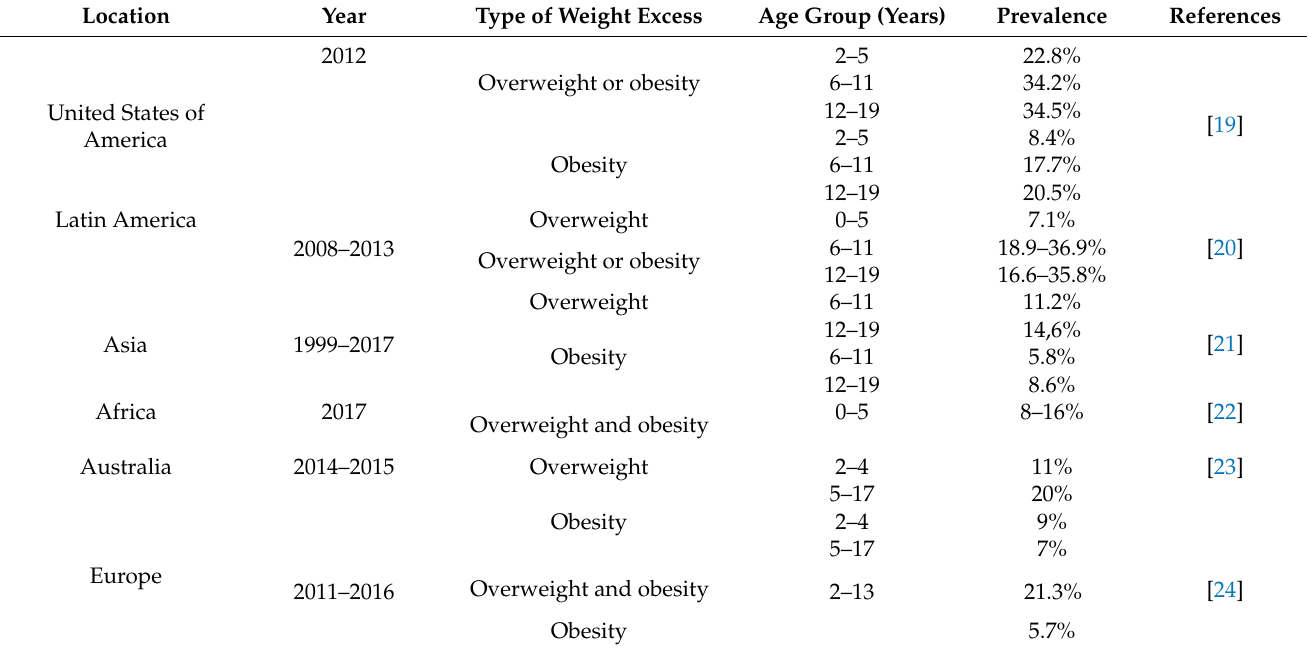
Table 1. Childhood obesity prevalence in relation to geographical